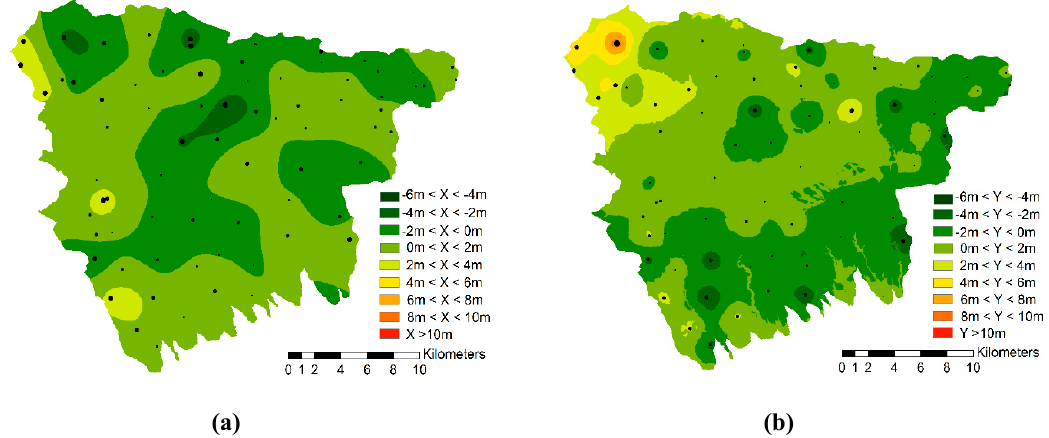
Figure 14. Error maps along the two axes. ( a ) Error X; ( b ) error Y. The black points indicate the 75 GCP dataset. The size of each point represents the error value; the larger points correspond to higher error values.